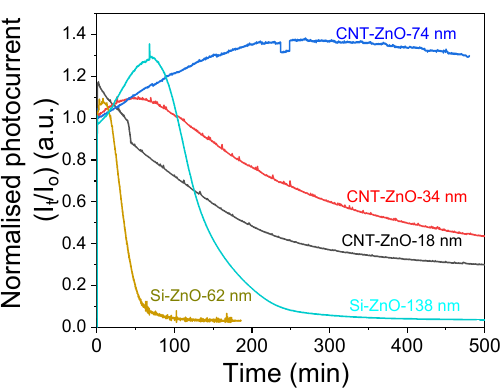
Figure 7. Photocurrent stability measured in a 0.1 M NaOH solution (pH 12.7), under a 1 sun illumination and a bias of 1.23 V RHE , for various ZnO thicknesses on Si and on Si-CNT. Table 1. State-of-art of carbon-ZnO composite material studied for photo-corrosion stability.